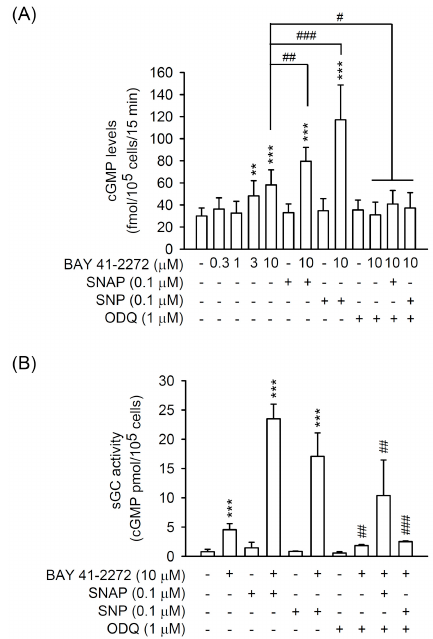
Figure 2. BAY 41-2272 increased the soluble guanylyl cyclase (sGC) activity and cyclic guanosine monophosphate (cGMP) formation in HSCs. (A) HSCs were preincubated with or without ODQ (1 μ M) sGC inhibitor for 15 min and then treated with BAY 41-2272 (0.3–10 μ M) in the presence or absence of S-nitroso-N-acetyl penicillamine (SNAP) (0.1 μ M) or sodium nitroprusside (SNP) (0.1 μ M) NO donors for another 15 min. ( B ) The cytosolic fractions from HSCs were mixed with or without ODQ (1 µ M), BAY 41-2272 (10 µ M), SNAP (0.1 µ M), and / or SNP (0.1 µ M) at 30 ◦ C for 20 min. The cGMP levels were assayed using enzyme immunoassay (EIA) kits. All data are expressed as mean ± SD ( n = 4). ** p < 0.01, *** p < 0.001 compared with the basal; # p < 0.05, ## p < 0.01, ### p < 0.001 compared with ( A ) BAY 41-2272 (10 µ M) alone and ( B ) the corresponding BAY 41-2272 with or without SNAP or SNP.